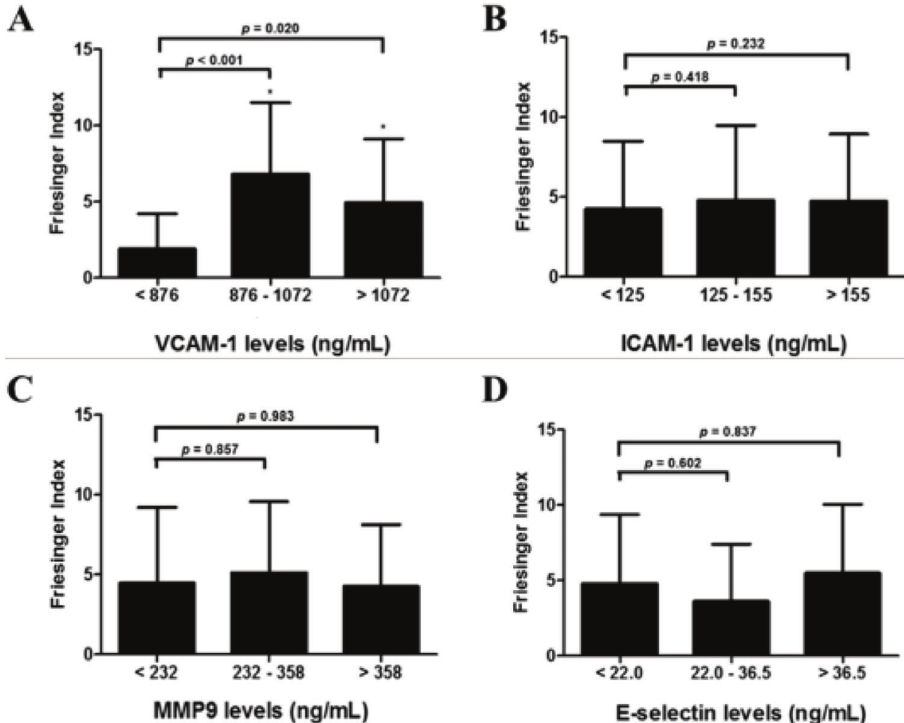
Figure 1 - Friesinger Index in patients undergoing coronary angiography for the first time stratified by tertiles of serum protein levels. (A) Individuals with higher VCAM-1 concentrations ( X 876 ng/mL) are likely to have higher Friesinger Index values. Serum (B) ICAM-1, (C) MMP9 and (D) E-selectin levels were not associated with increased Friesinger Index values. Data are shown as the mean ± SD. * represents a significant difference compared with the 1 st tertile. Table 3 - Logistic regression analysis: influence of increased VCAM-1 concentrations ( 4 876 ng/mL) on the extent of the coronary lesion. Dependent